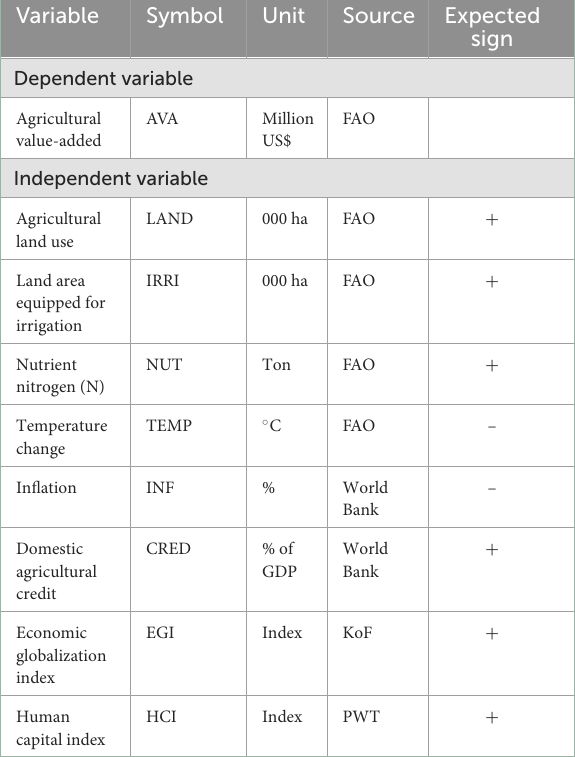
TABLE 1 Variables and data sources of the research.